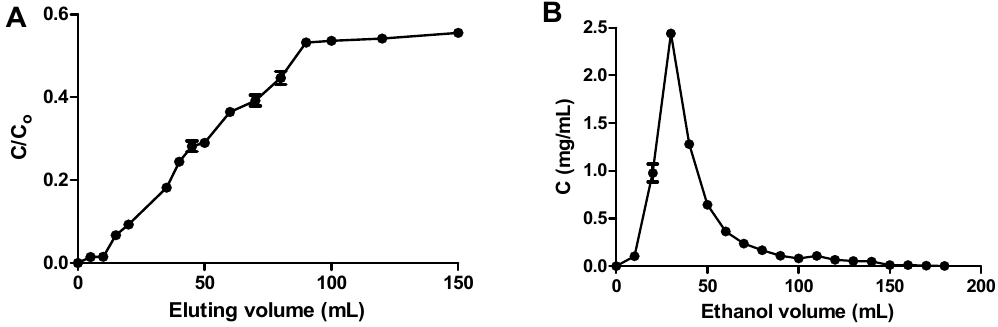
Figure 5. Dynamic breakthrough ( A ) and desorption ( B ) curves for OPL total flavonoids on XAD7HP.